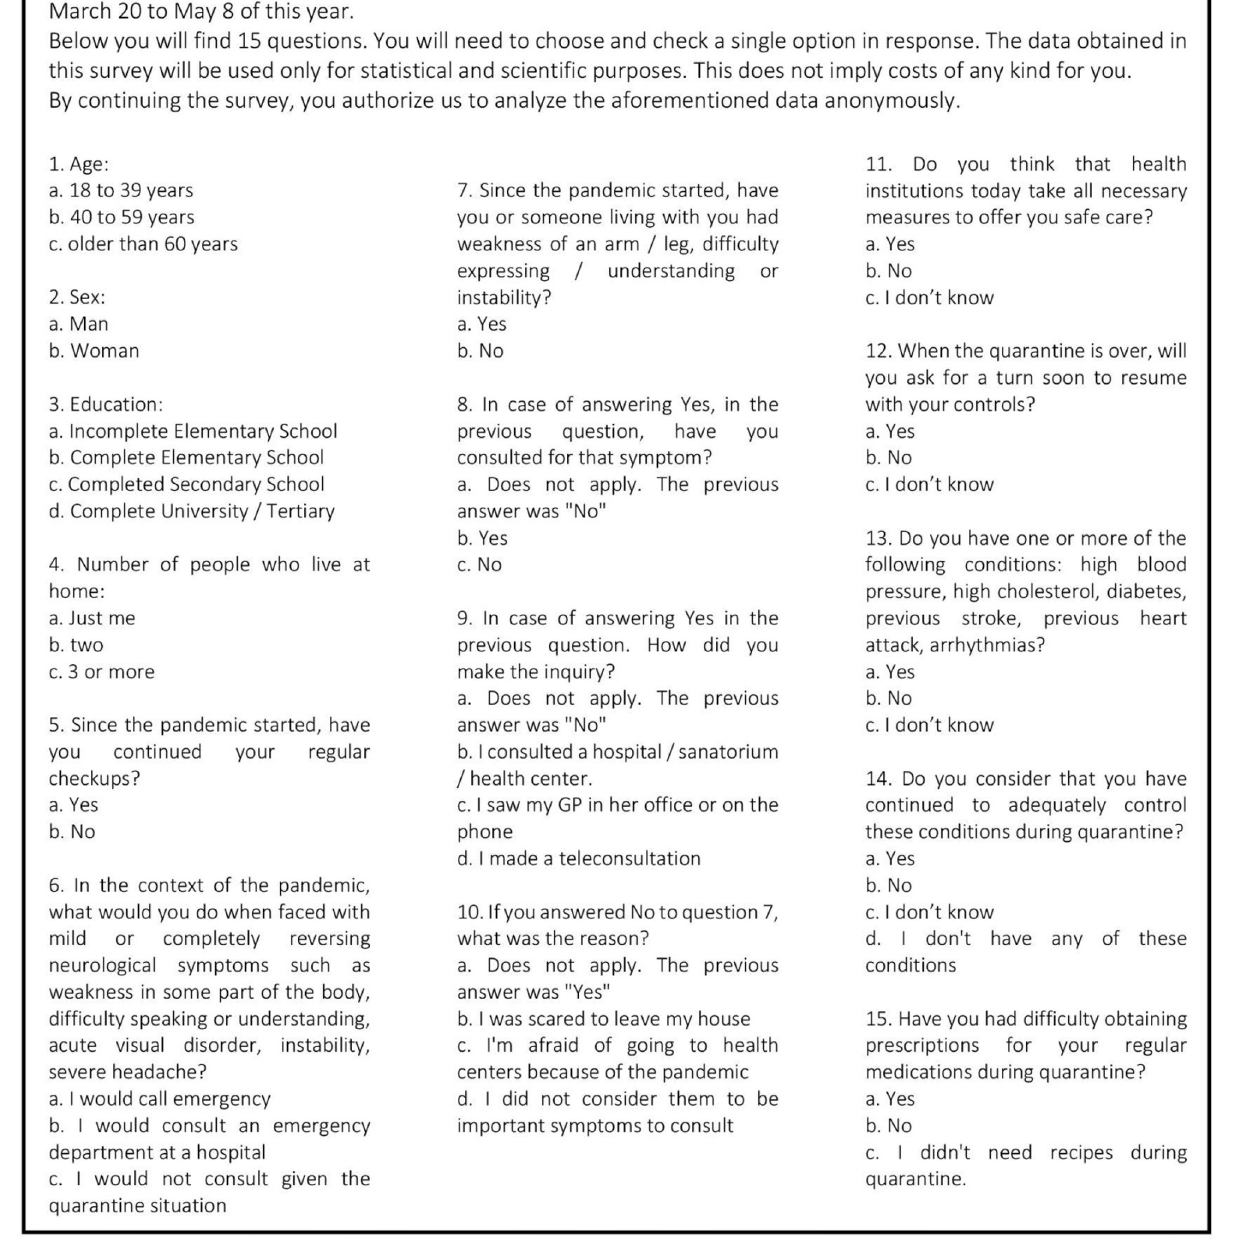
FIGURE 1 | Model of questionnaire used for this survey (translated to English language). The percentages of responses for each question were calculated for the entire group and for several subgroups according to age, gender and presence of VRF. For statistical